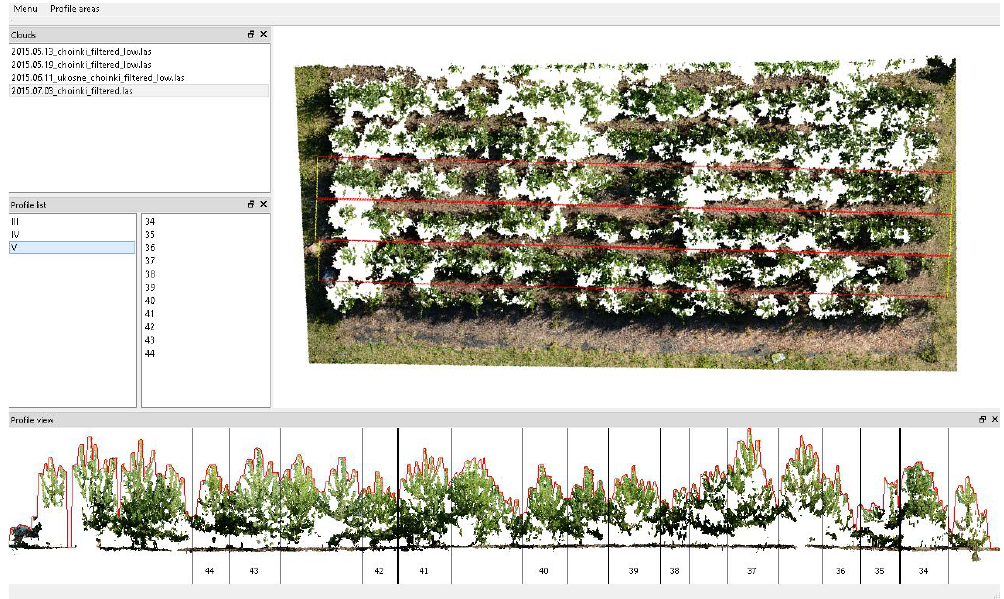
Figure 5. Graphical user interface of tree height measurement